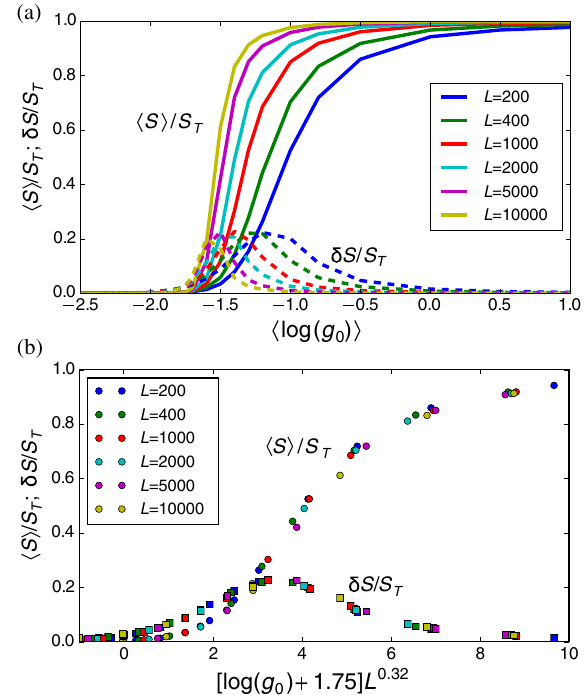
FIG. 4. (a) Entanglement entropy of eigenstates (solid lines) and its fluctuations (dashed lines) near the many-body locali- zation transition computed from the RG as described in the text for different chain lengths L . Both the entropy and its fluctuation are normalized by the expected thermal entropy of L ¼ Ll 2 . (b) Data collapse of h S i =S elementary blocks S 0 log T T and δ S=S obtained with the fitted correlation length exponent T ν ¼ 3 . 1 ( 1 = ν ¼ 0 . 32